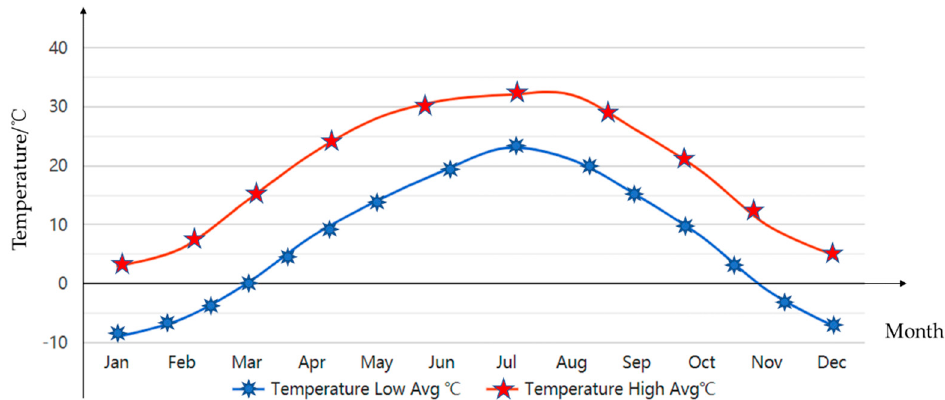
Figure 11. The temperature change in 2022 in Beijing.